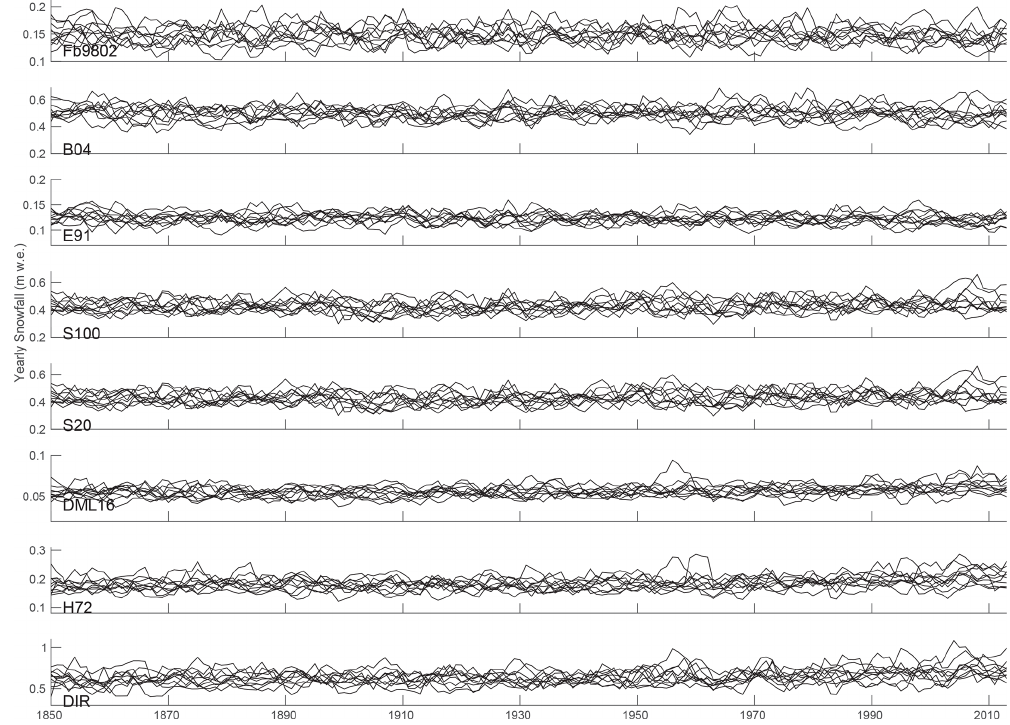
Figure 13. The scatter of the 10 members of CESM2 downscaling using ERA-Interim in the training reveals an uncertainty of 20% (standard deviation) and up to 40% at some ice core